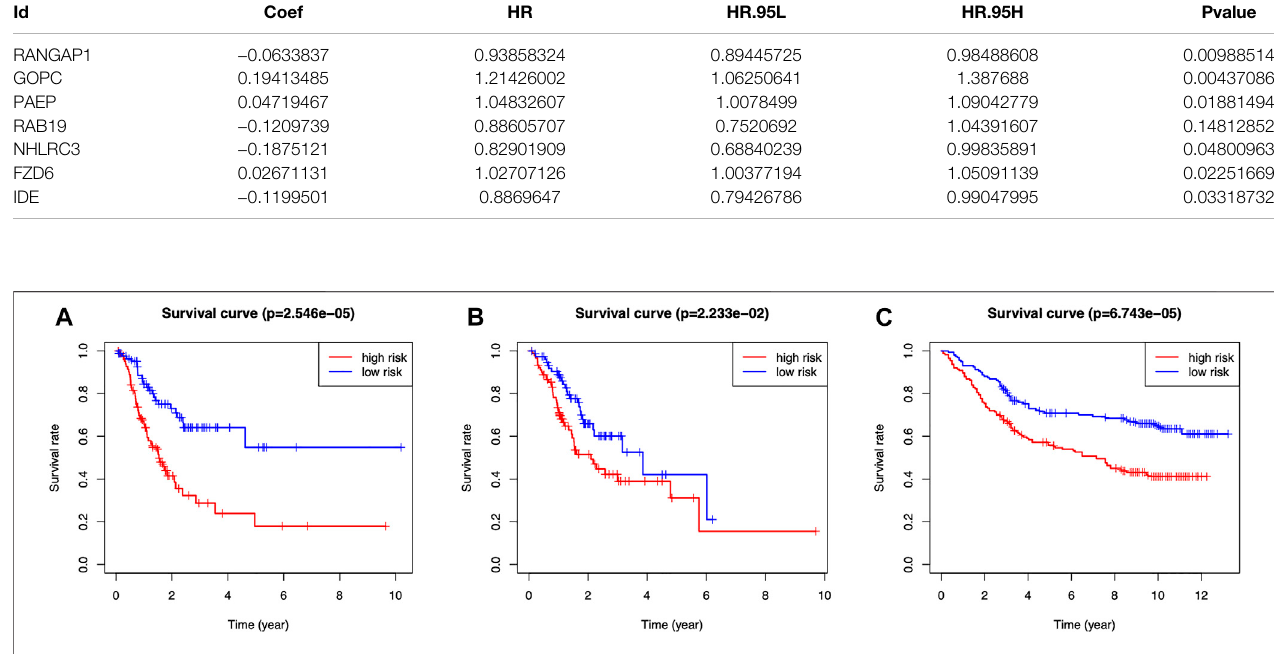
Frontiers in Cell and Developmental Biology |